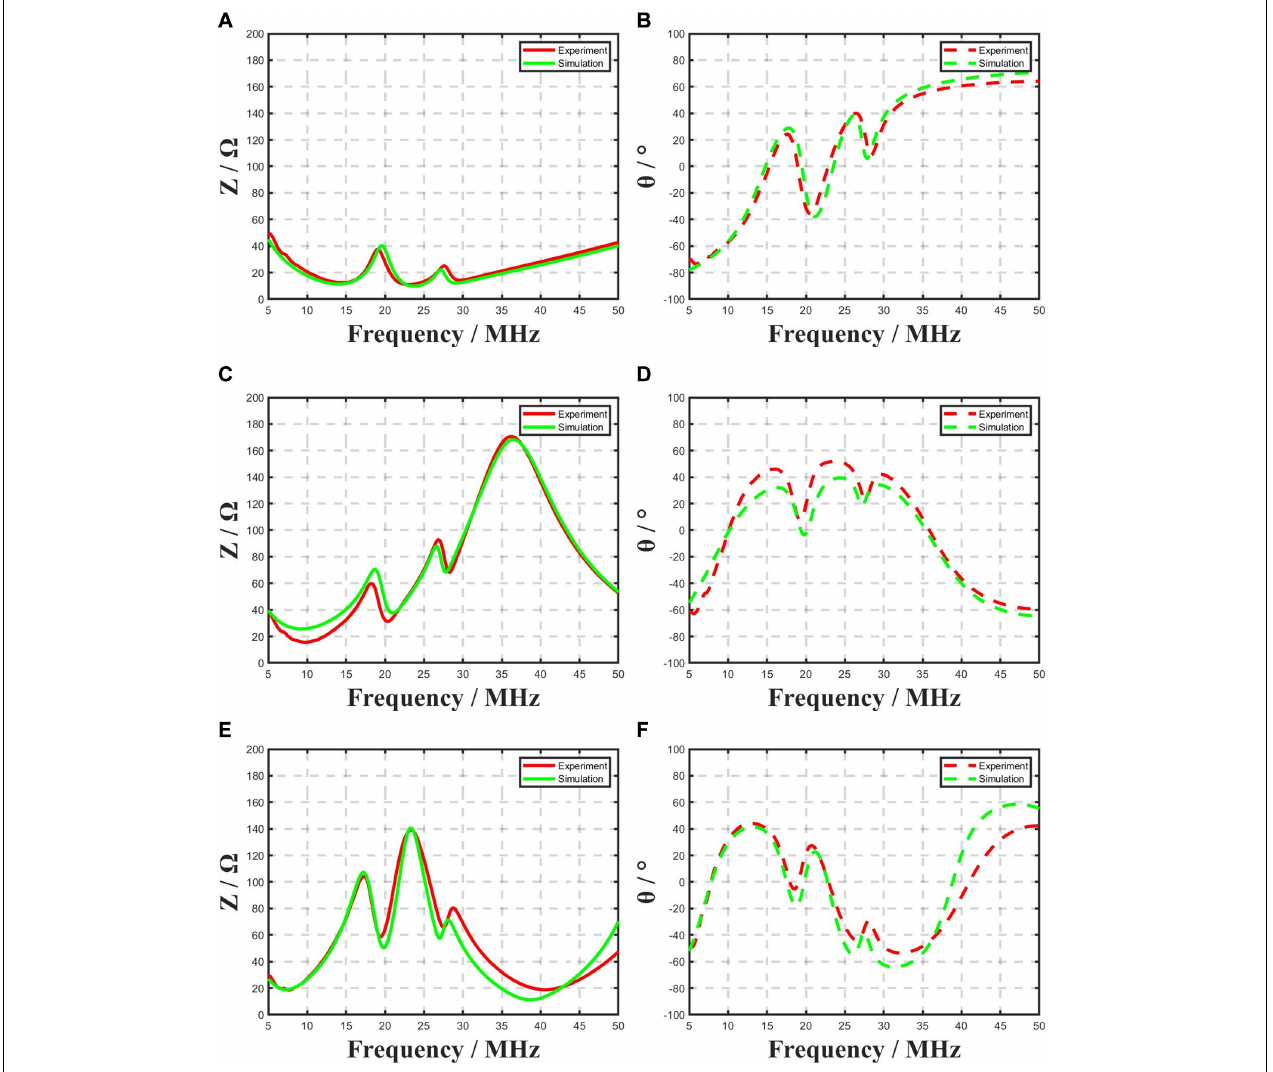
FIGURE 9 | The simulated and measured results of (A) the amplitude of 20MHz transducer with 0.5 m cable (B) the phase of 20MHz transducer with 0.5 m cable (C) the amplitude of No. 3 transducer with 1.5 m cable (D) the phase of 20MHz transducer with 1.5 m cable (E) the amplitude of No. 3 transducer with 2.5 m cable (F) the phase of 20MHz transducer with 2.5 m